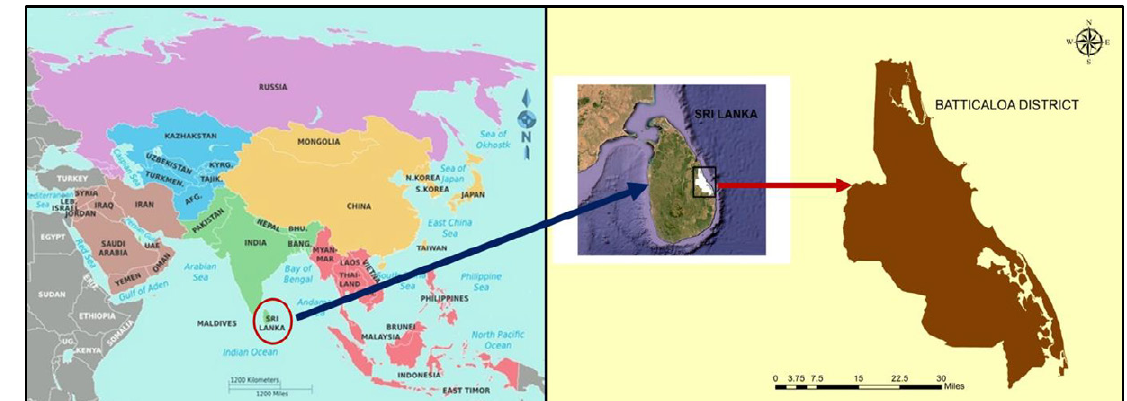
Fig. 1: Geographic location of the study area in urban Batticaloa area of Sri Lanka